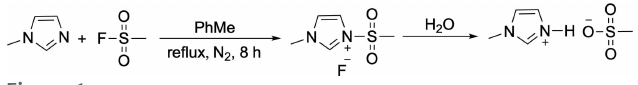
Figure 1 Synthetic scheme for the synthesis of imidazolium-based salts, paired with sulfate anion via SuFEx click chemistry